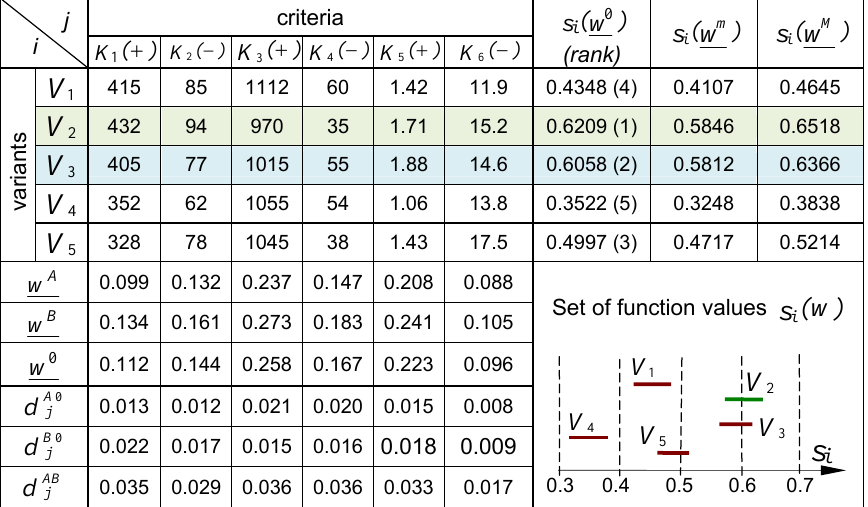
Table 2 – Criteria Matrix, basic solution and extreme